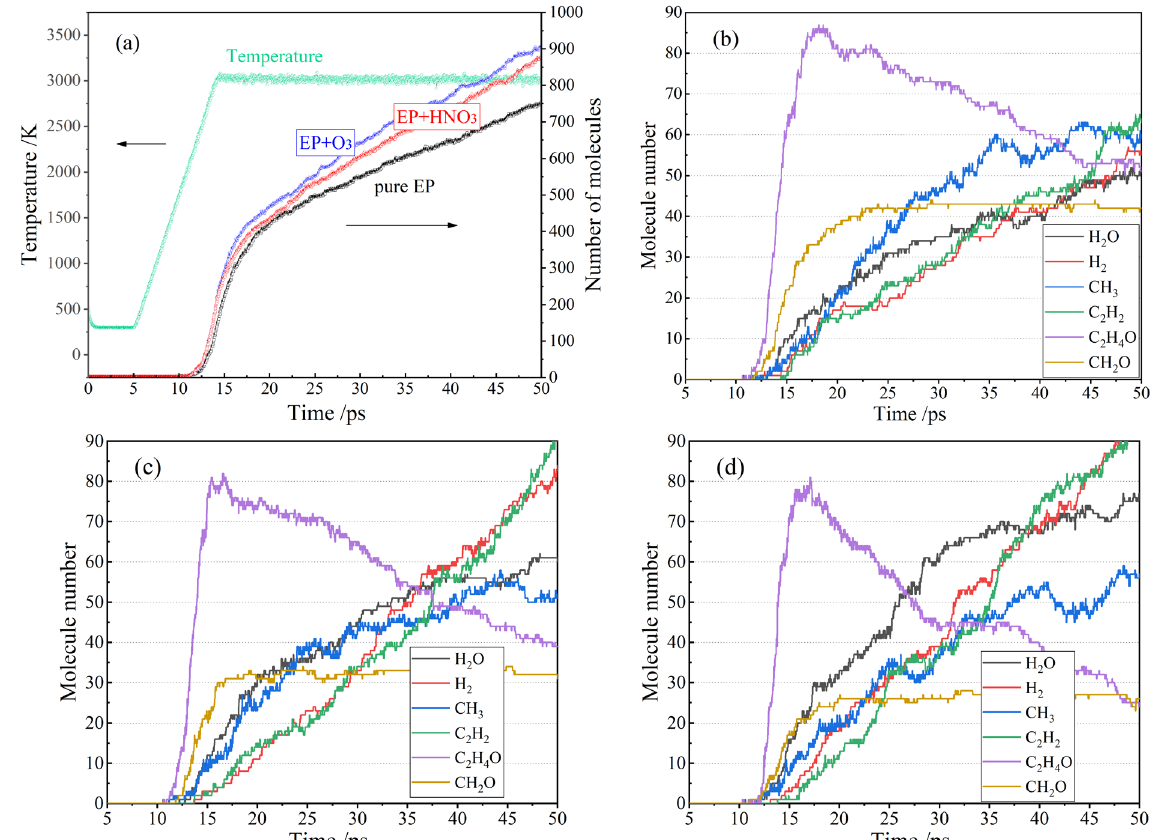
Figure 3. The amount of the produced small molecules increasing with time in reactive MD simula- tion process of crosslinked EP polymers under thermal impact: ( a ) temperature and total molecule number; ( b ) pure epoxy polymer; ( c ) containing nitric acid molecules; ( d ) containing ozone mole- cules.